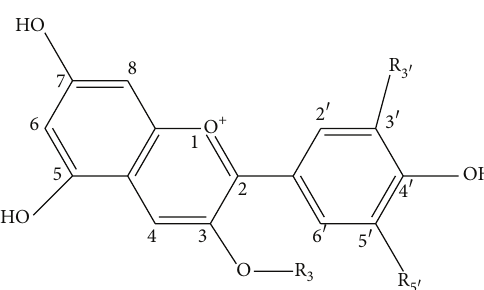
Figure 1: Flavylium form of 3-glycosides of six common antho- cyanidins. R 3 󸀠 and R 5 󸀠 are H and H for pelargonidin (Pg); OH and H for cyanidin (Cy); OH and OH for delphinidin (Dp); OCH 3 and H for peonidin (Pn); OCH 3 and OH for petunidin (Pt); OCH 3 and OCH 3 for malvidin